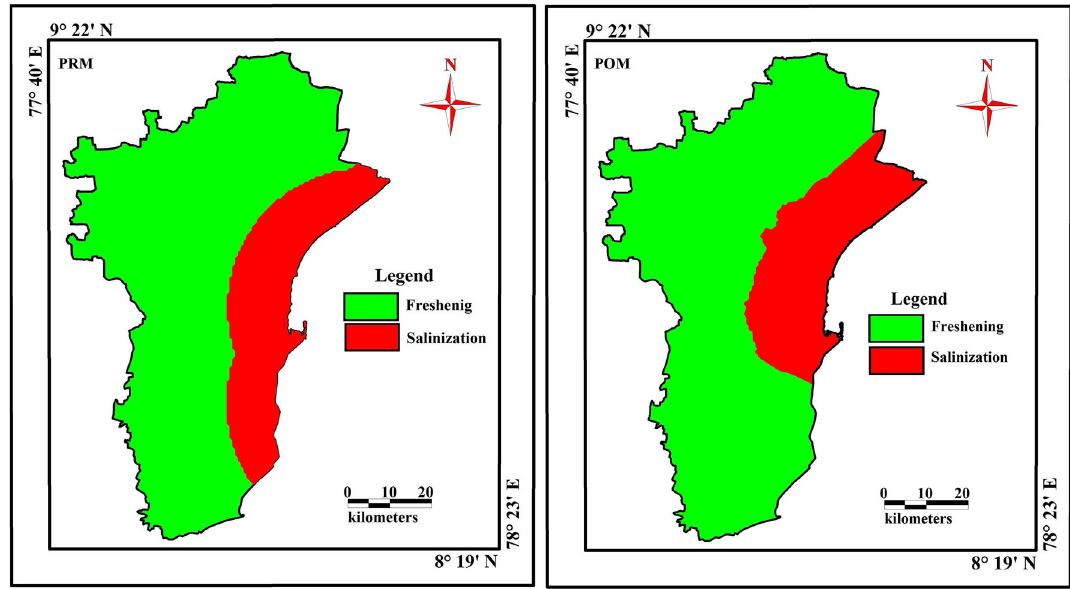
Fig. 10 BEX distribution in the groundwater of study area, according to Stuyfzand